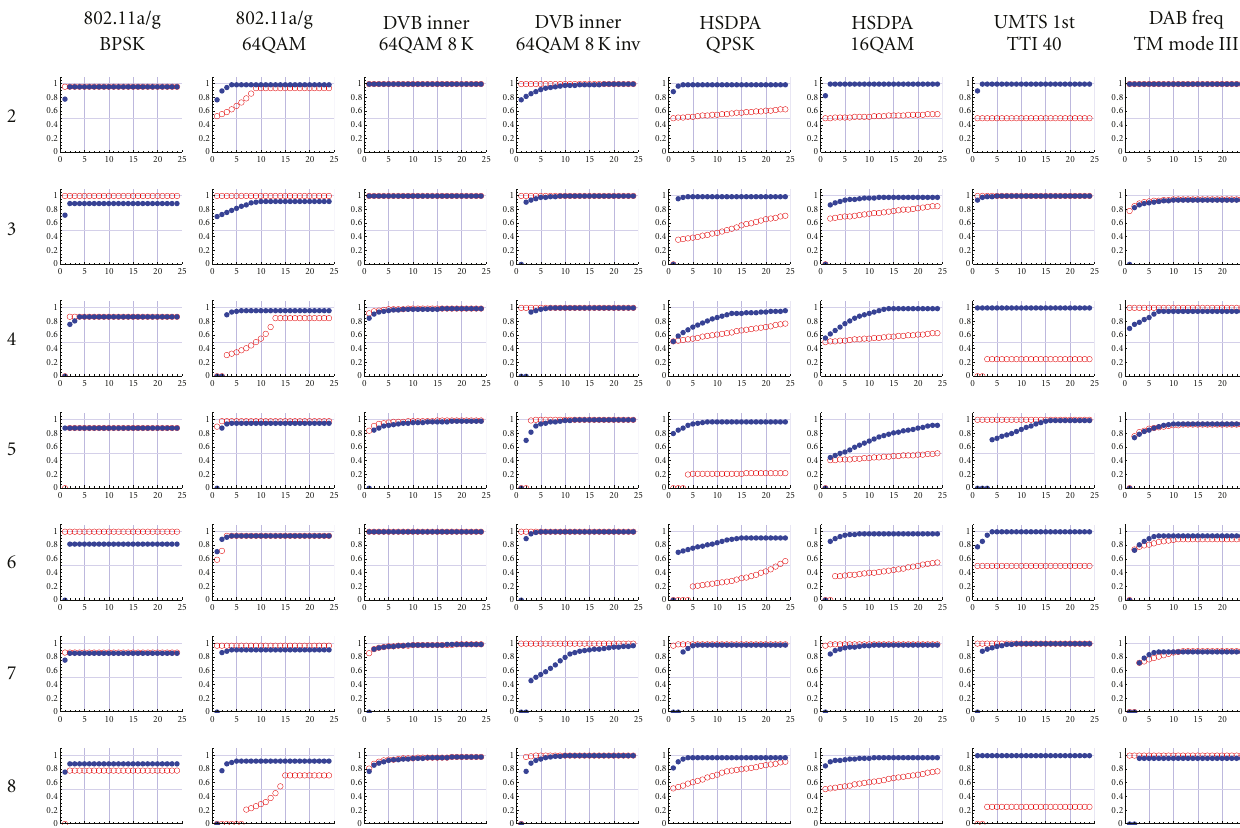
Figure 4: Conflict Resolving Memory e ffi ciency. Utilization of memory bandwidth for 8 interleaving functions (columns) versus number of memory banks (rows) and Access/Reorder Queue depth ( x -axis).